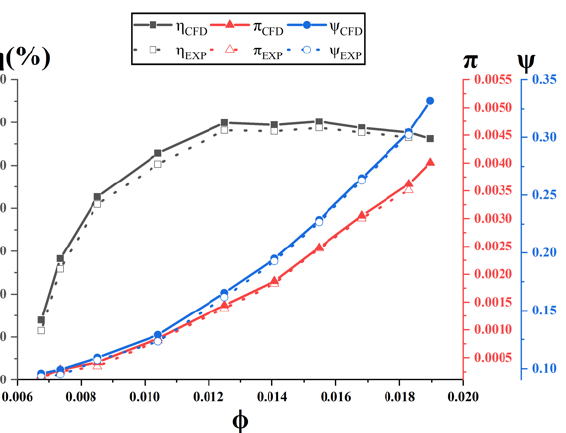
Figure 8. Comparison of experimental and numerical simulation results at the design speed (2900 rpm).